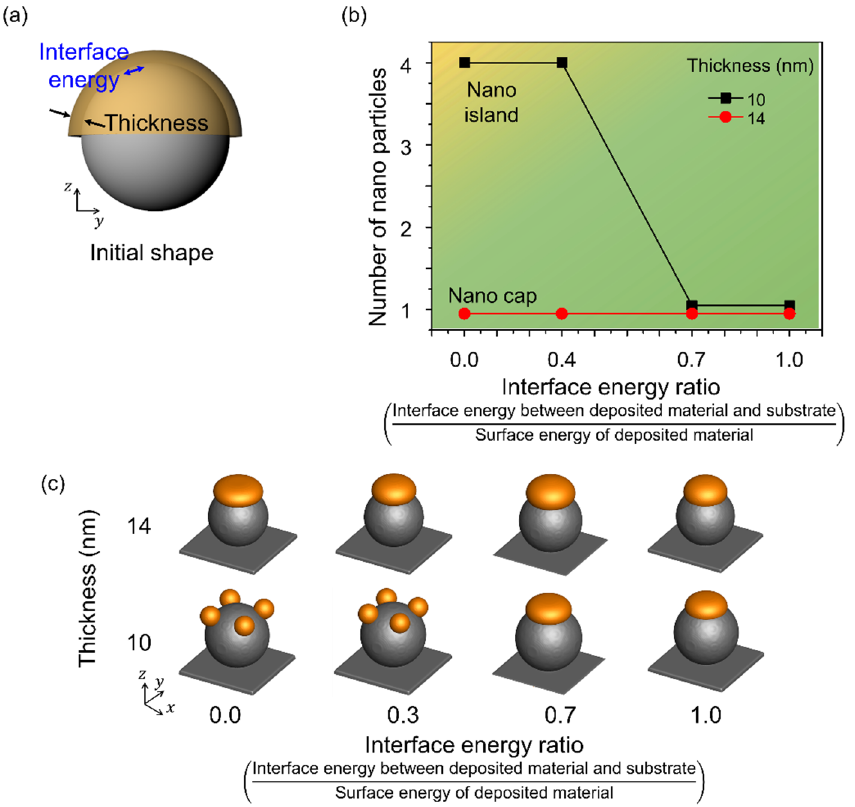
Figure 6. Effects of the interface energy between the spherical patterns and deposited materials. ( a ) Schematic of the simulation considering the interface energy between the deposited material and the spherical pattern and the deposition thickness. ( b ) Number of nanoparticles formed on the surface of the spherical pattern with change in deposition thickness and interface energy. The yellow and green areas correspond to the formation of nano-islands and nano-caps, respectively. ( c ) Equilibrium morphologies of nanostructures formed in thermal dewetting according to the interface energy ratio and thickness.